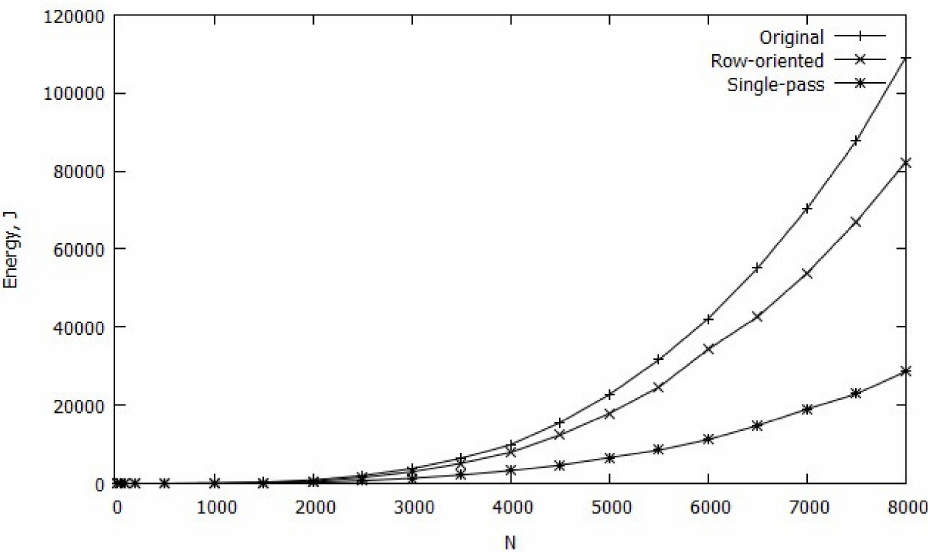
Figure 6. Dependence of the energy consumed on the problem